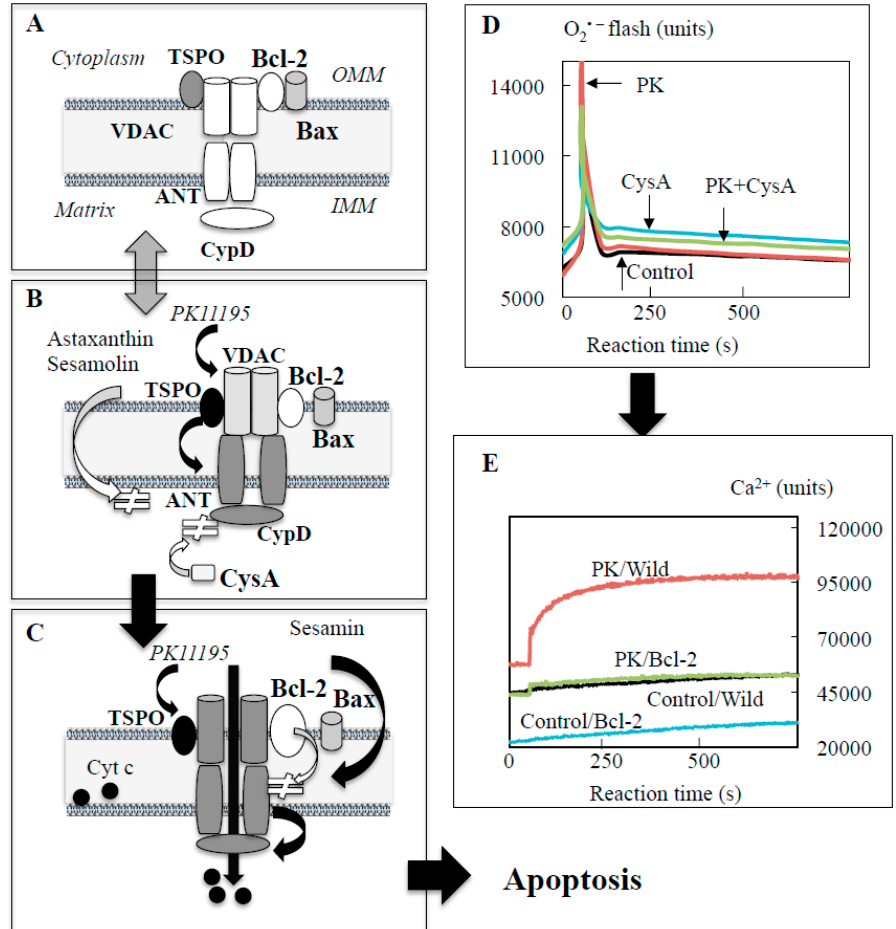
Figure 2. Step-wise formation of the mitochondrial permeability transition pore (mPTP) induced by PK11195 and regulation of cyclosporine A (CysA) and Bcl-2. A . The mPTP at the resting state. B